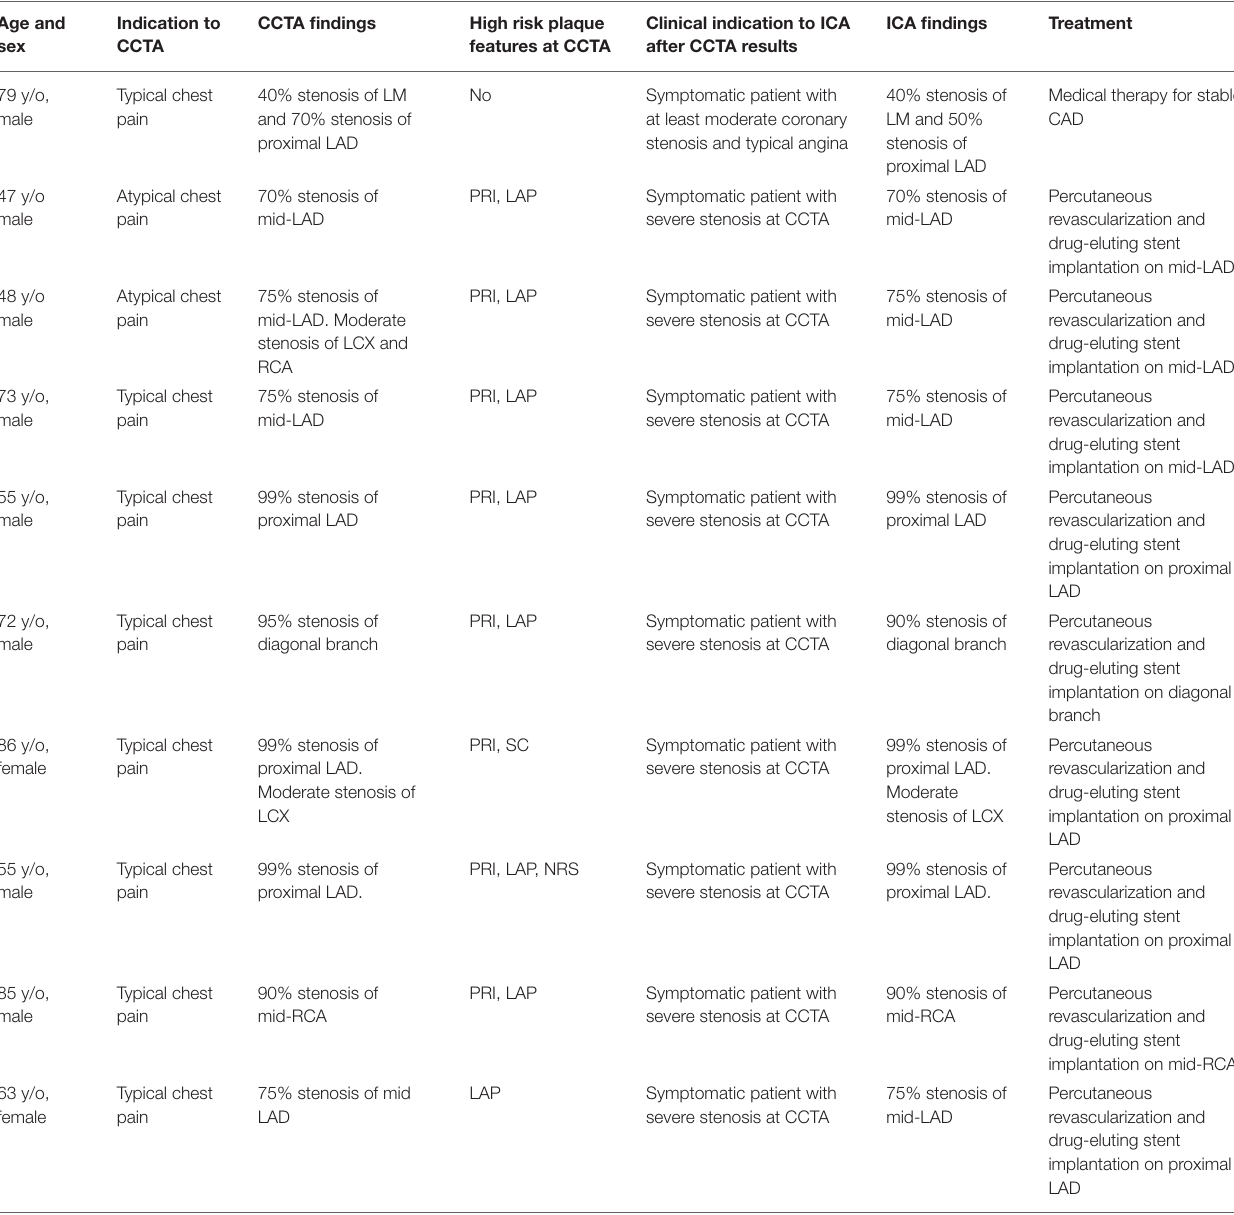
TABLE 2 | Clinical, CCTA, and ICA characteristics of patients who underwent non-deferrable ICA. Age and